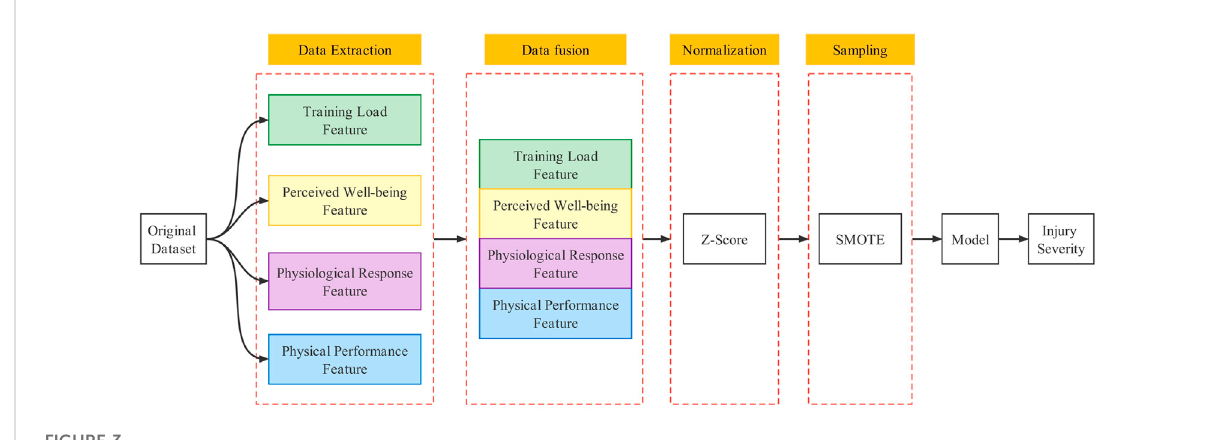
FIGURE 3 Comparison of reference integration